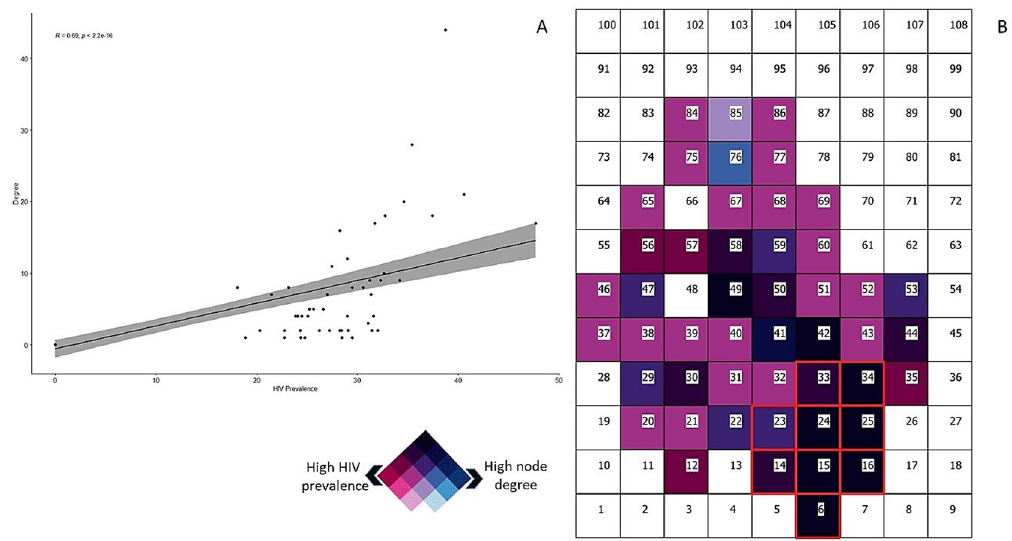
Fig 3. Association between node degree and HIV prevalence of the corresponding cell. A) Correlation between HIV prevalence of the node and the corresponding node degree. The line illustrates the regression line showing the positive association between the node connectivity (degree) and the HIV prevalence of the corresponding cell (p < 0.005). B) Bivariate map showing areas with high node degree and high HIV prevalence (dark cells). Numbers within the cells illustrate the labels of each cell (node). The nodes included within the HIV high-risk area are delineated in red.